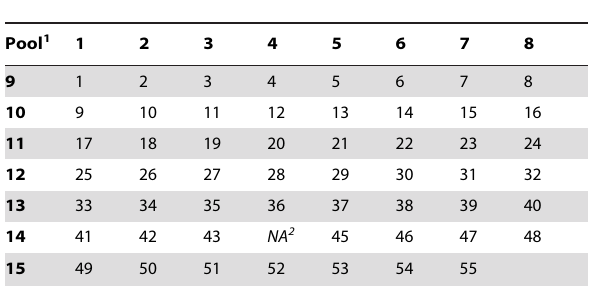
Table 1. Peptide pool